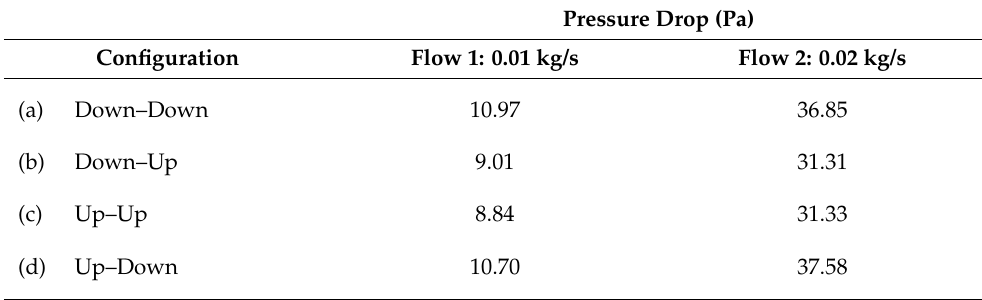
Table 7. Pressure drop in the system.